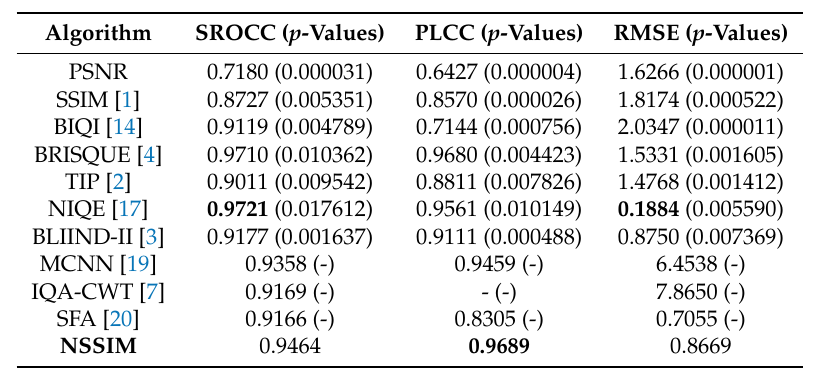
Table 7. Comparison with ten existing IQA algorithms on LIVE II dataset (145 Gaussian blur images). We take Spearman’s rank order correlation coefficient (SROCC), Pearson linear correlation coefficient (PLCC) and root mean square error (RMSE) as evaluation indexes. In each column, the best performance value is marked in boldface.